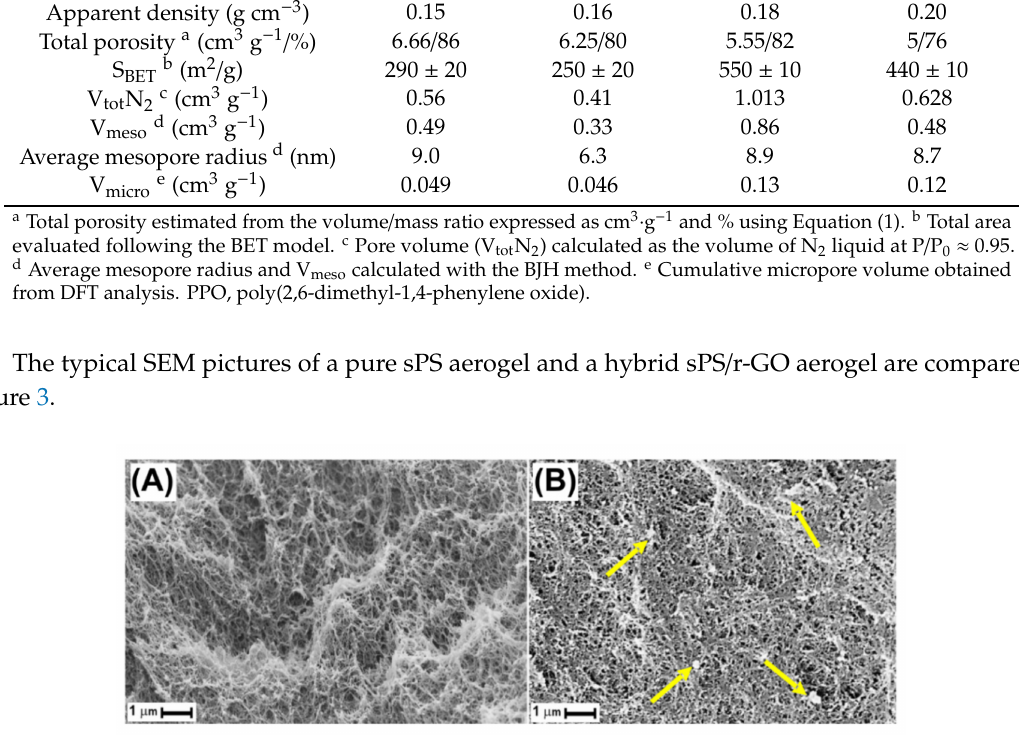
Table 1. Summary of the apparent density (g cm − 3 ), total porosity (cm 3 g − 1 ), pore volume (cm 3 g − 1 ), mesopore radius (nm), and surface area (S BET , m 2 g − 1 ) of the pure polymer aerogels and hybrid polymer aerogels with 10 wt.% polymer of the total solvent weight and 80 / 20 polymer / r-GO weight fraction. sPS